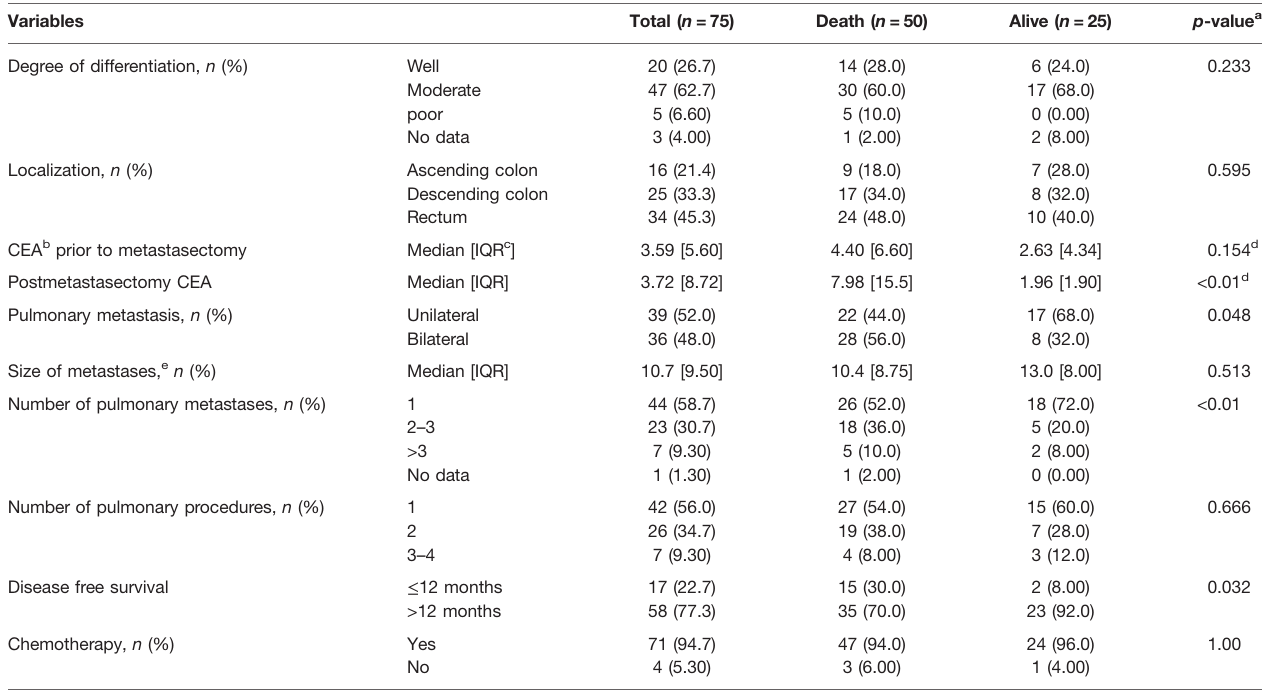
a Chi square test. b CEA: carcinoembryonic